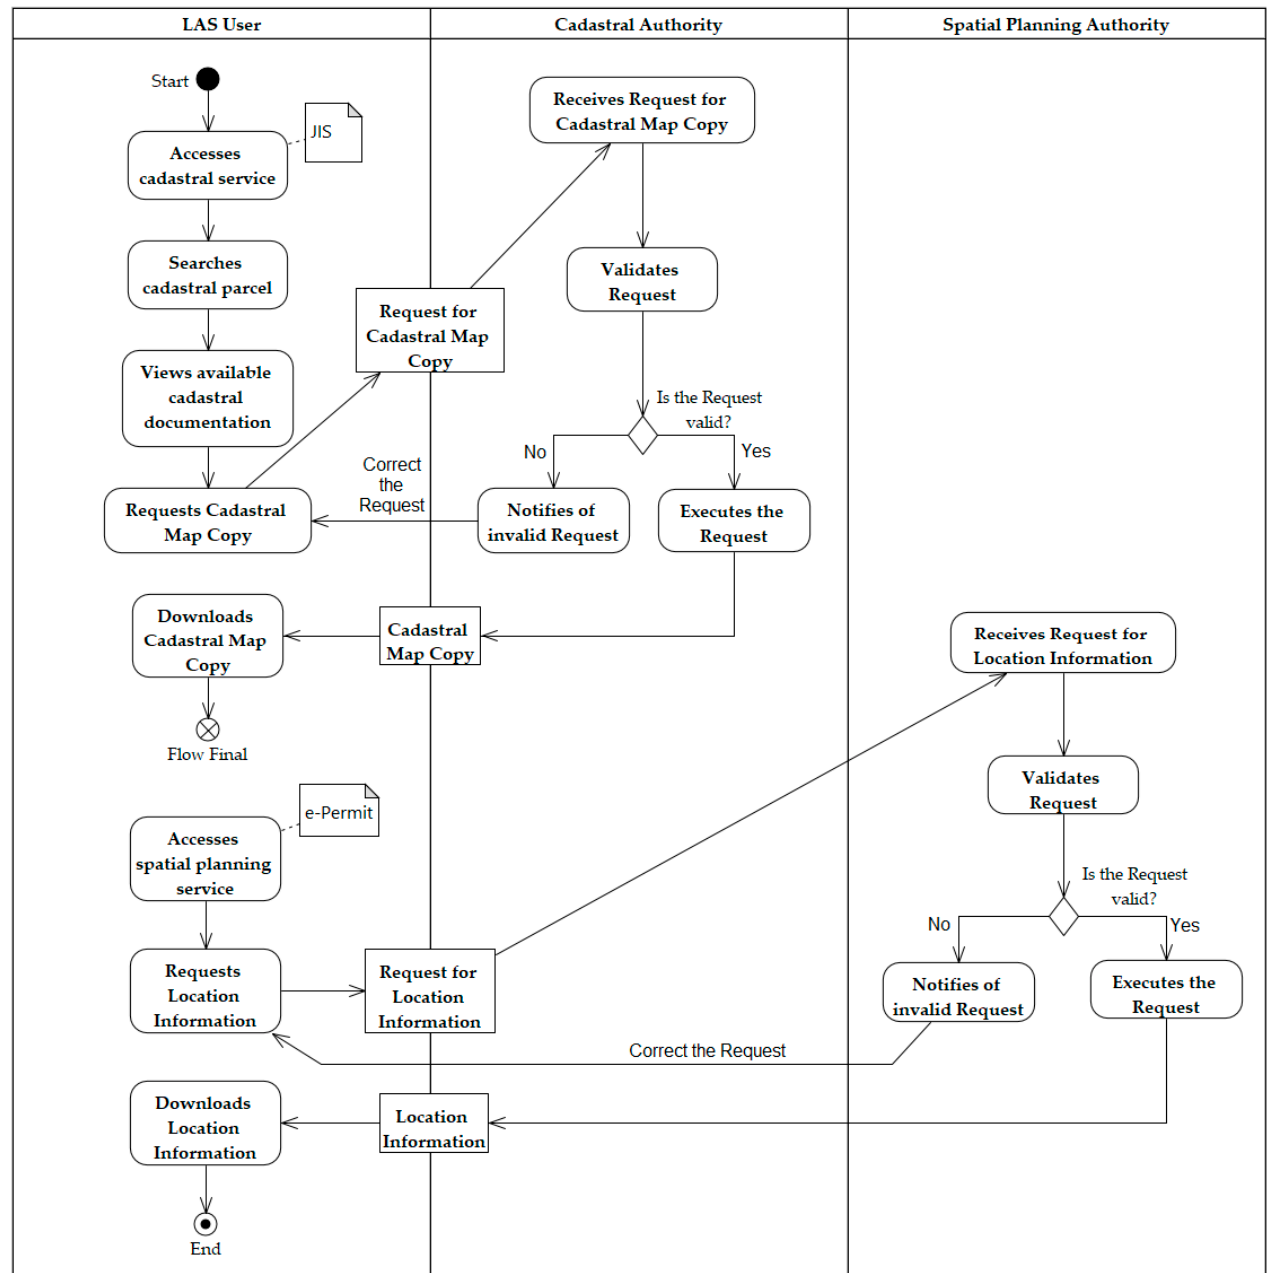
Figure 3. Activity diagram for the process of dissemination of land use constraints. Source: Own compilation.